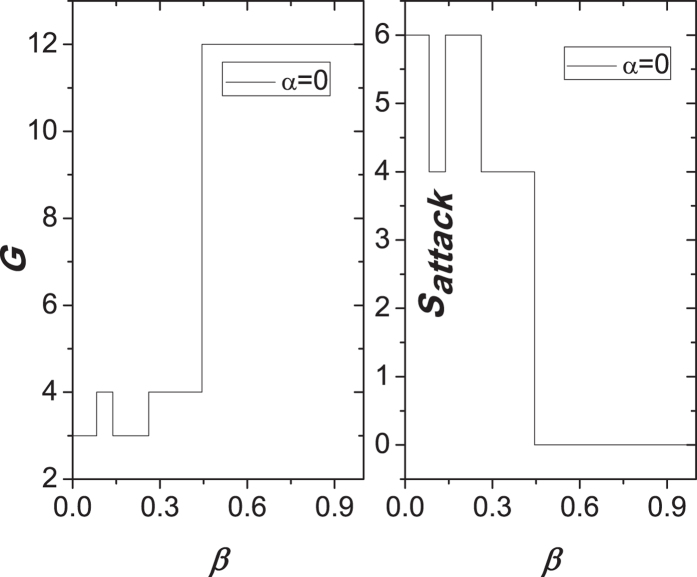
Correlation between two measures (G and Sattack) and the parameter β after removing a node in Fig. 4.